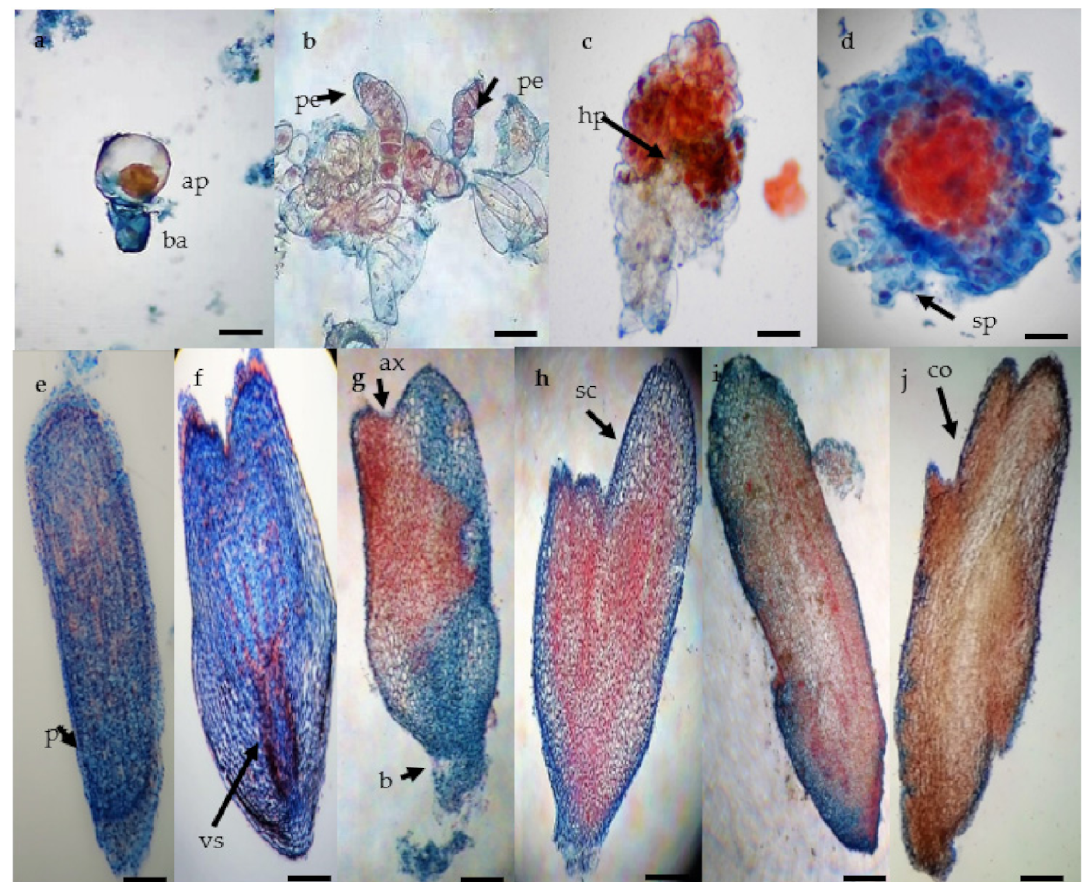
Figure 2. Histological analysis of somatic embryogenesis process in Agave tequilana Weber ‘Chato’. ( a ) asymmetric cell division giving rise to small apical cell (red) and basal cell (blue) (bar 50 µ m), ( b ) proembryos showing group of cells with one side of rapid cellular division (black arrow) (bar 100 µ m), ( c ) late proembryo stage with dyed suspensor in blue and hypophysis (bar 100 µ m), ( d ) specific formation pattern of the globular stage with vestigial suspensor structures (bar 100 µ m), ( e ) late globular stage with the formation of the protoderm (bar 200 µ m), ( f ) late globular stage (bar 200 µ m), ( g ) early scutellar stage showing an apical axis (black arrow) (bar 200 µ m), ( h ) late scutellar stage (bar 200 µ m), ( i ) early coleoptillar stage (bar 200 µ m), ( j ) late colleoptillar stage (bar 200 µ m). Apical cell (ap), basal cell (ba), proembryo (pe), hypophysis (hp), suspensor (sp), protoderm (pt), pro-vascular strands (vs), apical axis (ax), basal axis (bx), scutellum (sc), and coleoptile